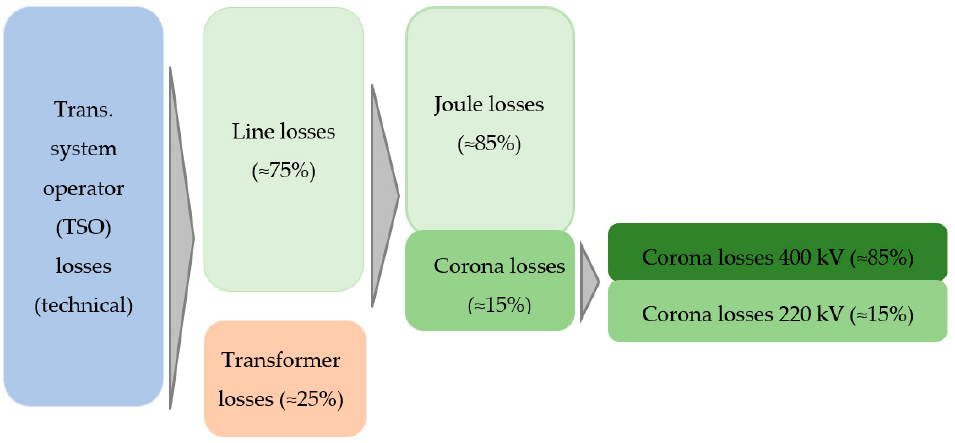
Figure 3. General classification of losses in the transmission system.